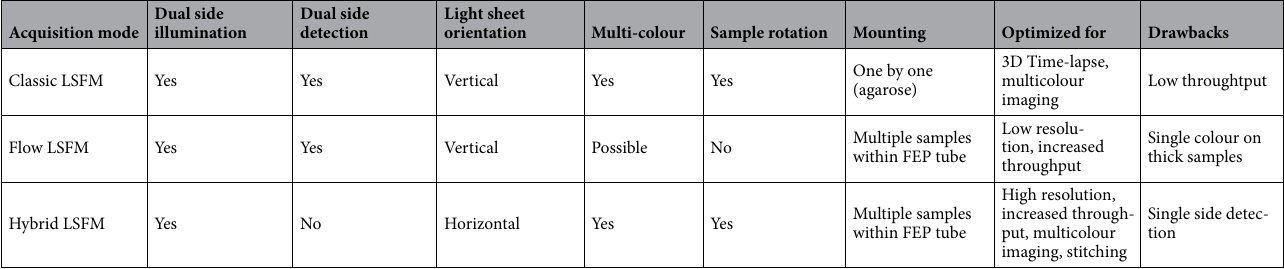
Table 1. Summary of the different acquisiton modes available within the Flexi-SPIM